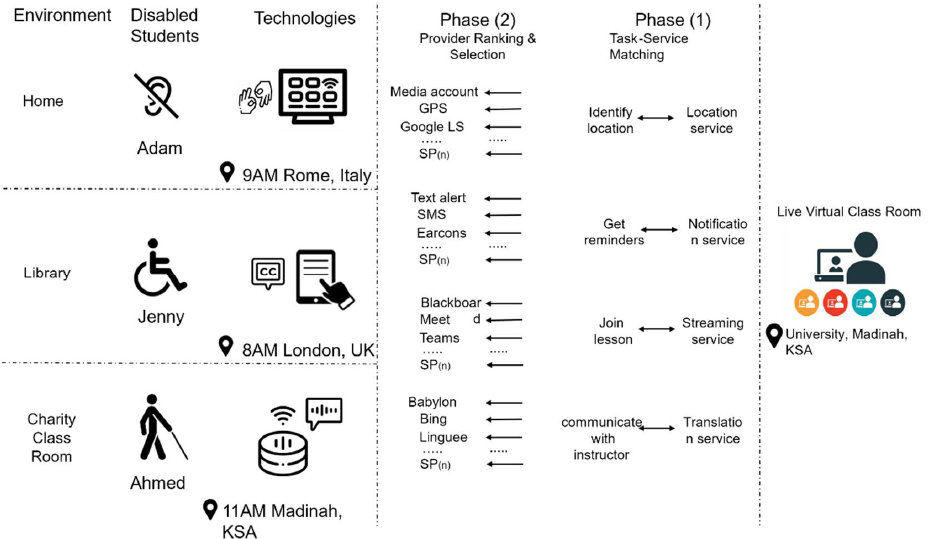
Figure 1. Our working scenario of online learning service selection for students with disabilities . We